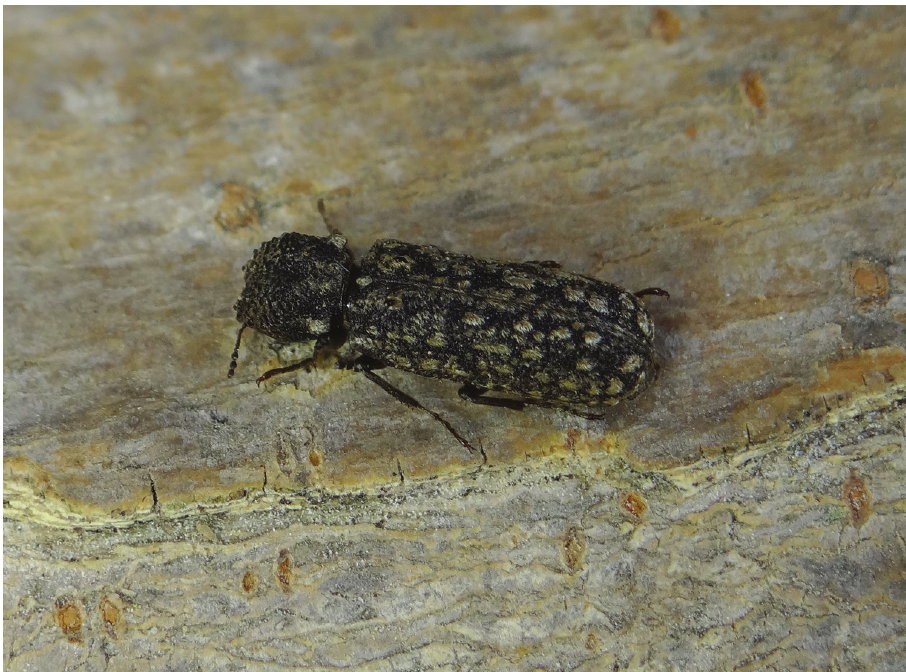
Figure 1. Adult of Lichenophanes varius from the Nature Reserve Bosco della Fontana (Italy) (photo by G. Scaglioni,